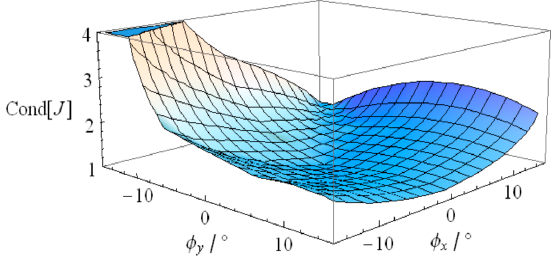
Figure 18. Condition number of the 2-DOF SPM.